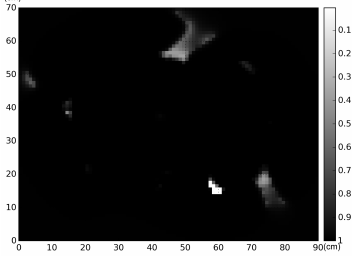
Figure 23. HMM parameter estimation of a 22 for unobserved